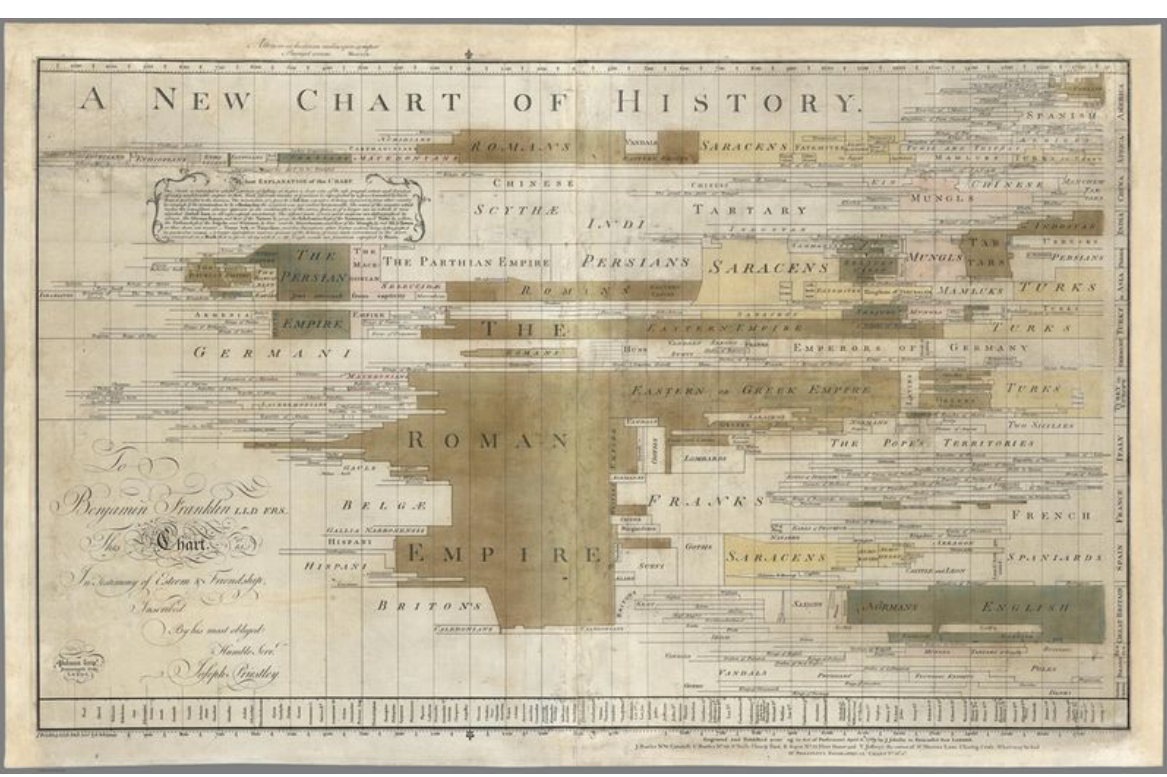
Figure 20. Joseph Priestley’s widely circulated New Chart of History (1769). Image courtesy of the David Rumsey Map Collection, David Rumsey Map Center, Stanford